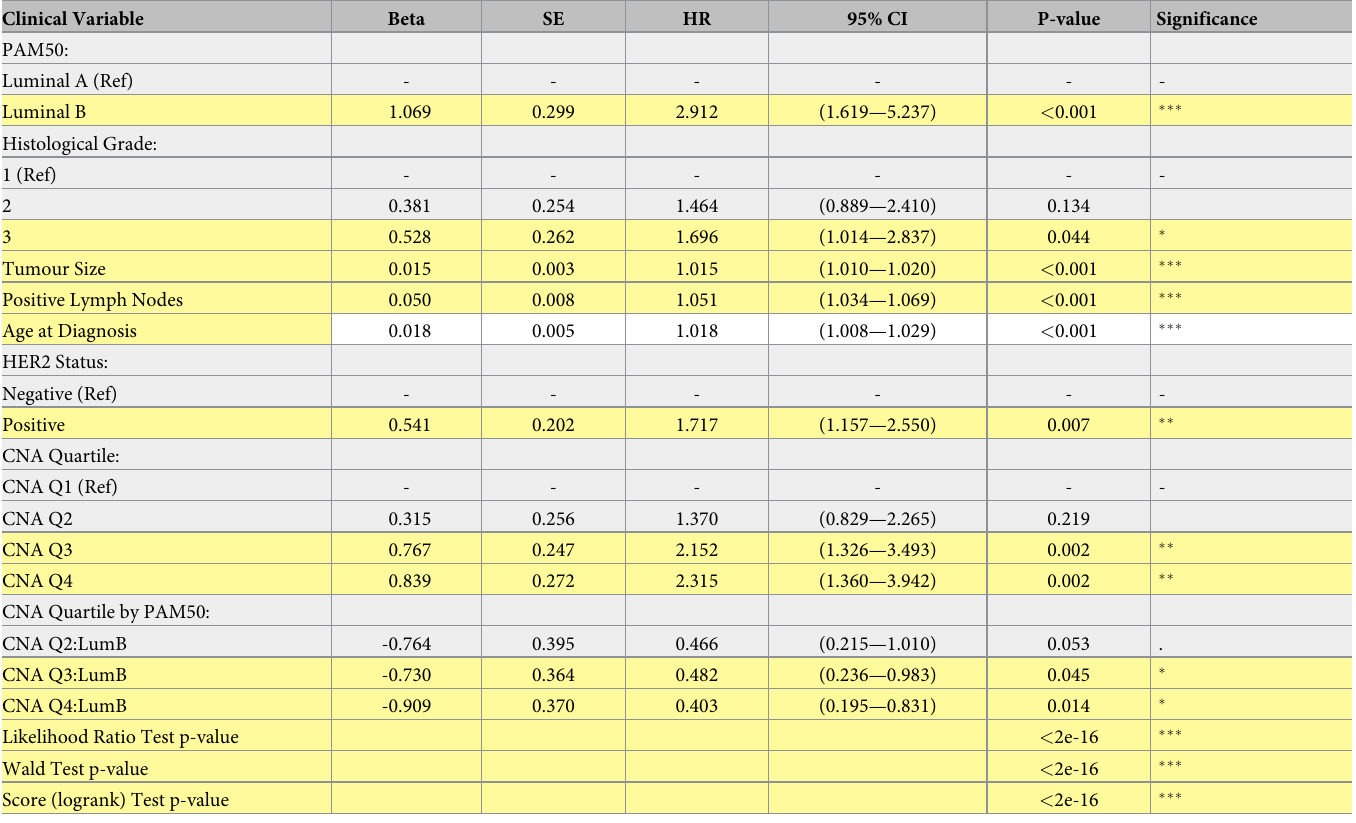
Table 1. Final multivariable Cox PH model with selected clinical variables, CNA Quartiles and interactions. Clinical